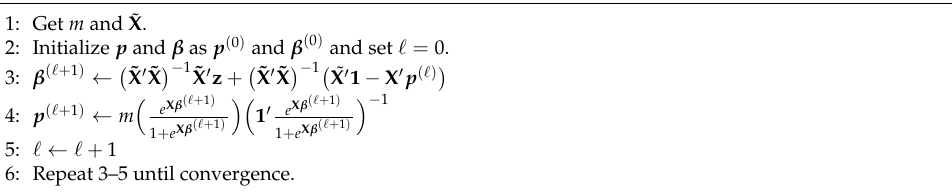
Algorithm 1 Proposed algorithm for prediction of PV power